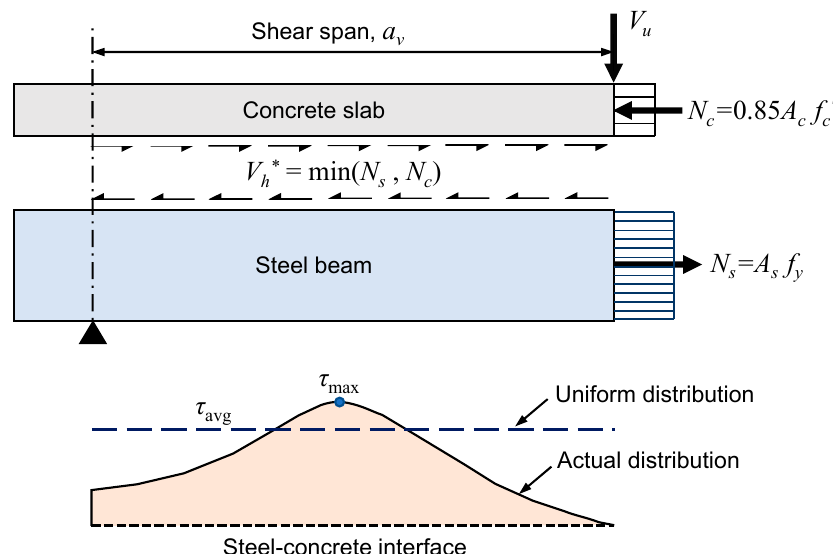
Figure 15. Distribution of horizontal shear stresses along steel–concrete interface.